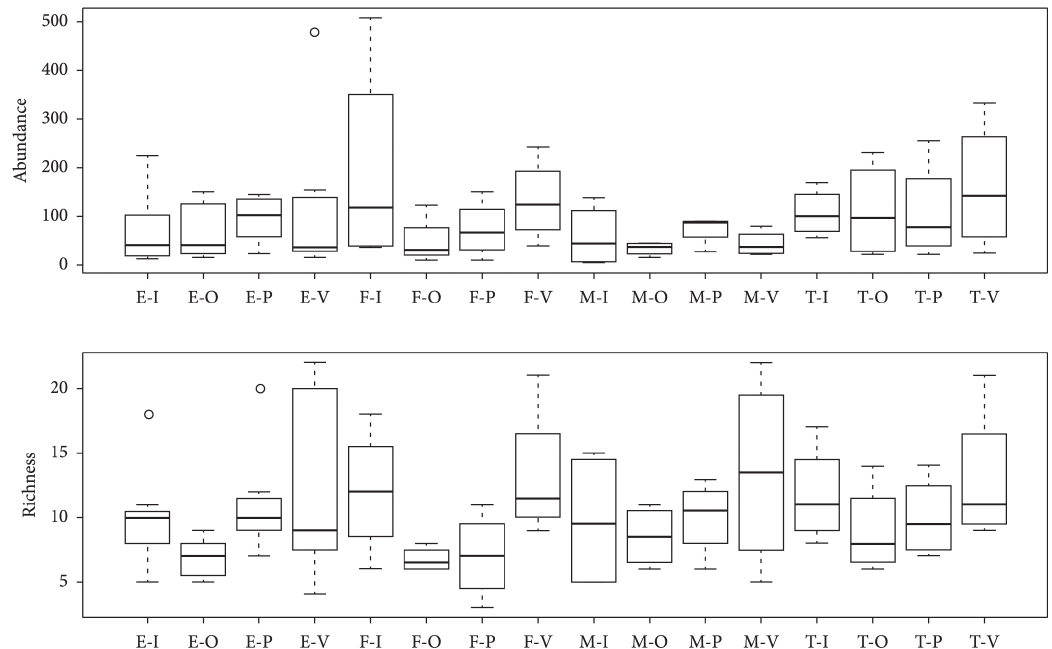
Figure 2. Abundance and richeness of the Chironomidae genera in the streams in Alto Uruguai region, Rio Grande do Sul, Brazil. E: Erechim, F: Faxinalzinho. M: Marcelino Ramos, T: Três Arroios. I: winter, P: Spring, V: Summer, O: